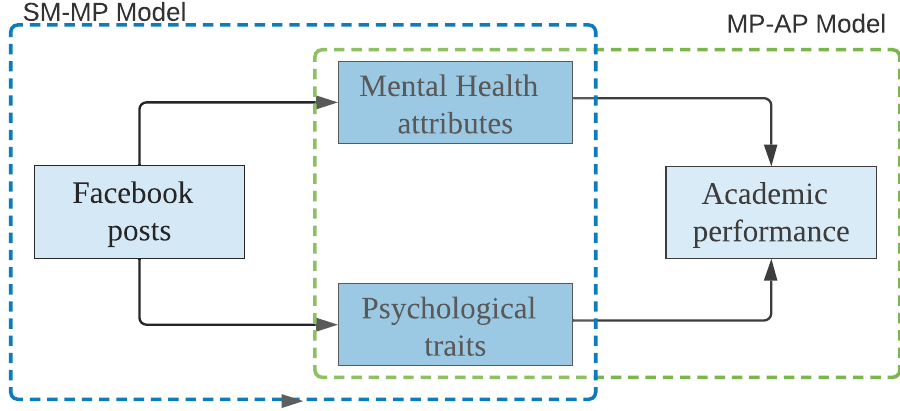
Figure 1. High-level architecture of the academic performance prediction